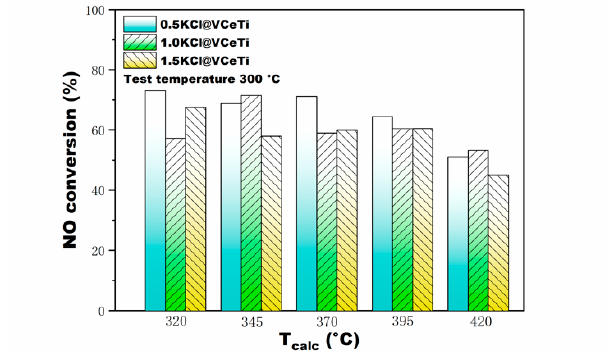
Figure 4. NO conversion of three n(K)/n(V) of KCl poisoned V 2 O 5 -Ce(SO 4 ) 2 /TiO 2 catalyst at different T calc . The test temperature was 300 °C.